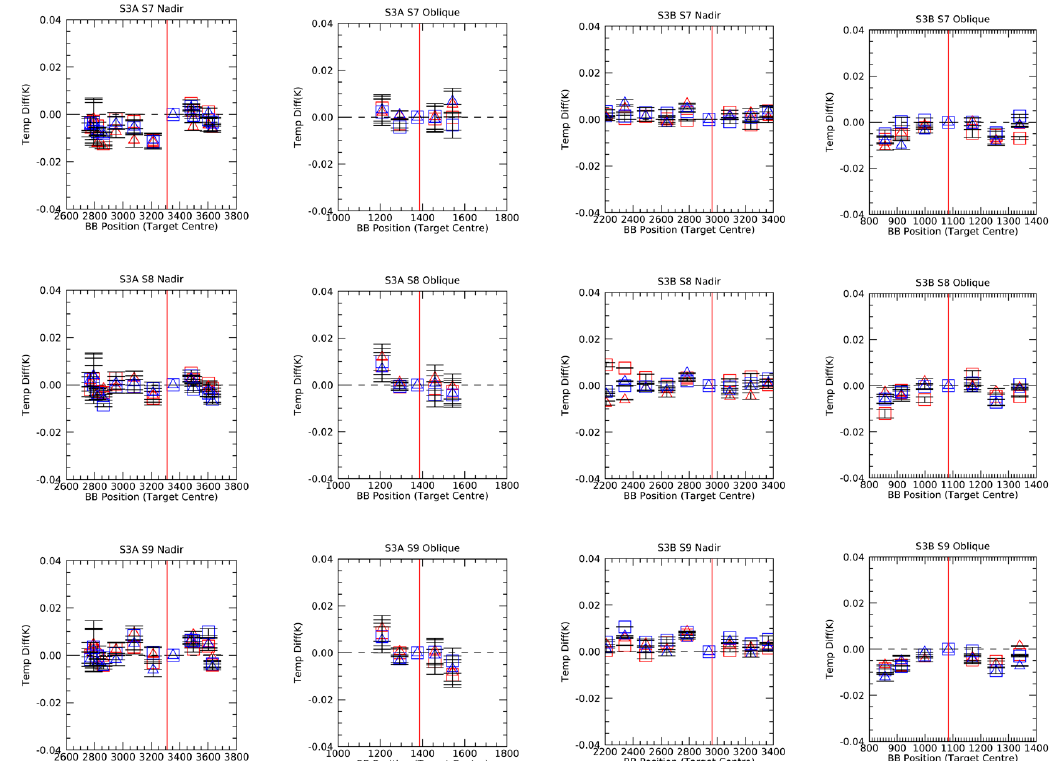
Figure 11. Results for calibration at different positions around the earth view for a scene temperature of 300 K. Plots show the relative difference in BT as compared to the values at center of the earth views which is indicated by the red line. Note that fewer measurements for SLSTR-A were possible due to operational issues of the BB motors. These were resolved and the full scan for SLSTR-B could be performed. ☐ = Detector 1, Integrator 1; ☐ = Detector 1, Integrator 2; Δ = Detector 2, Integrator 1; Δ = Detector 2, Integrator 2.